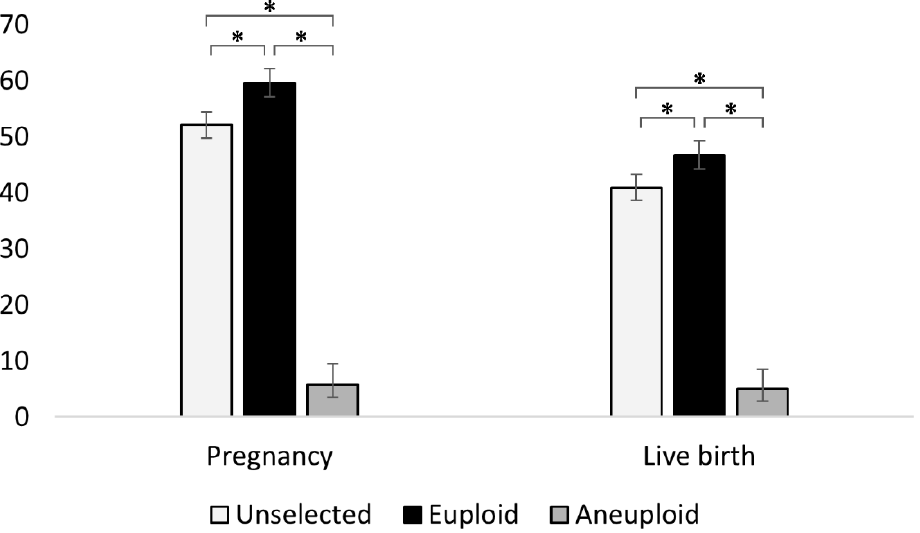
Figure 1. Effect of ploidy on pregnancy and live birth outcomes. Embryos diagnosed as euploid showed higher pregnancy and live birth rates as compared to embryos diagnosed as chromosomally abnormal or indeed to embryos not undergoing PGT-A selection. Sample population consisted of n = 1713 embryo transfers, which resulted in n = 892 pregnancies (unselected group); among these, retrospective PGT-A analysis discovered n = 878 pregnancies from n = 1472 euploid embryos and just n = 14 pregnancies from n = 241 aneuploid embryos. Similarly, there were a total of n = 700 live births (unselected group), which were found to be derived from n = 688 euploid embryos and n = 12 aneuploid embryos. Data presented as percentage (%) with 95% CI. * denotes statistically significant differences ( p < 0.01).